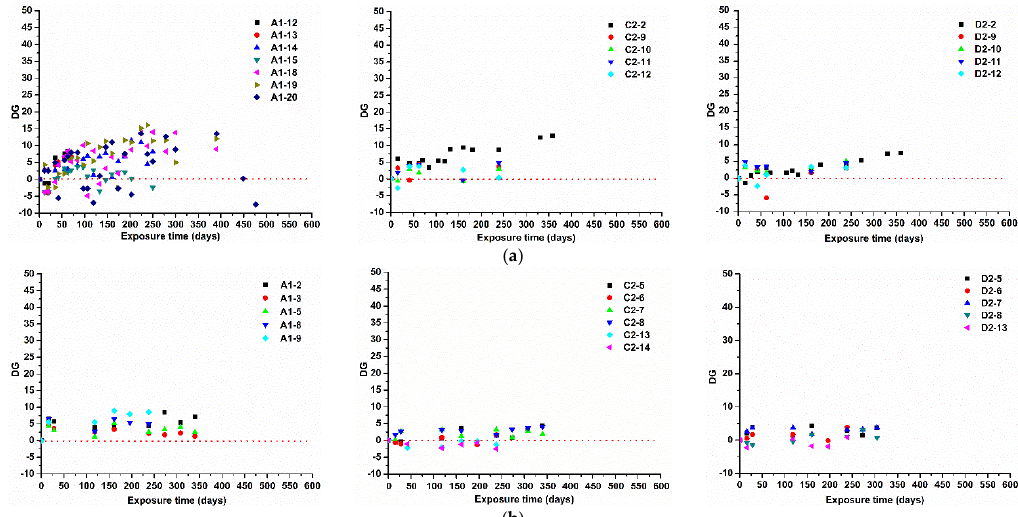
Figure 5. Evolution of gloss variation (Δ G ) of monolithic mirrors A1, C2, and D2 paint coatings during exposure time at ( a ) the seaside site and ( b ) desert site.